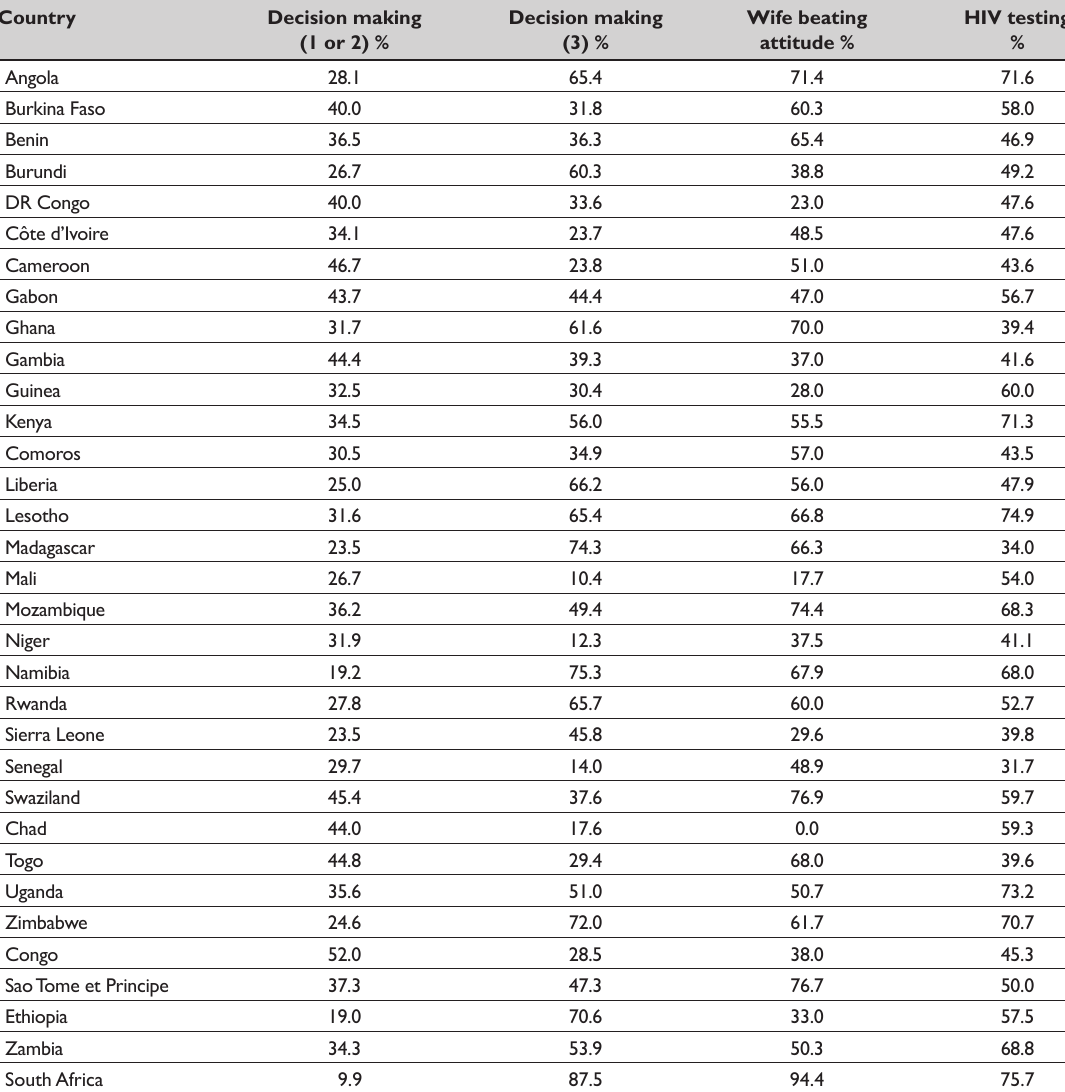
Table 1: Summary of percentage of women empowerment and HIV testing uptake, by country Country Decision making